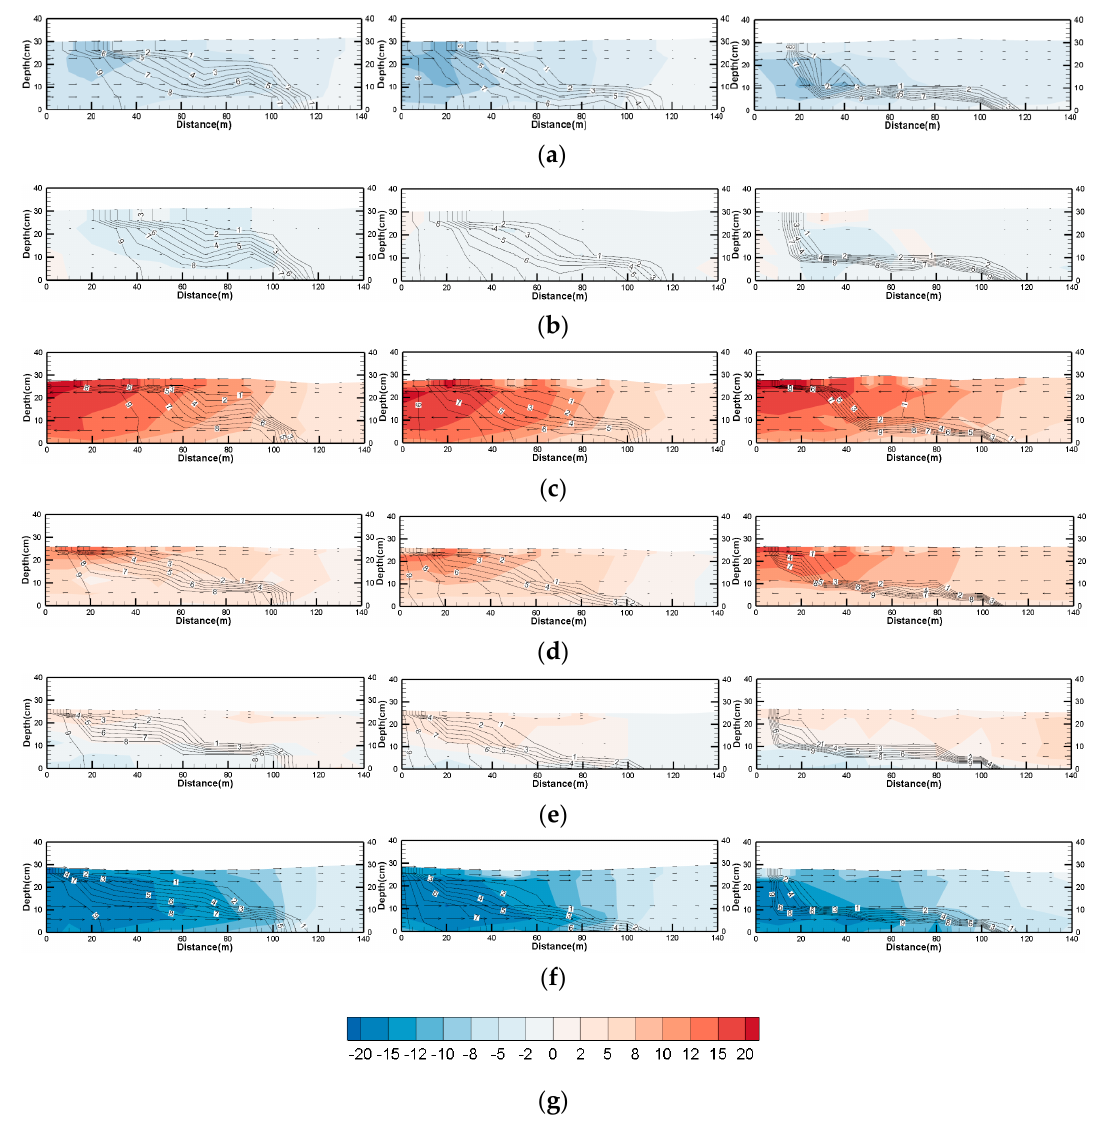
Figure 4. Salinity and velocity profiles of Case 3 (left figures), Case 4 (middle figures) and Case 5 (right figures) at each characteristic moment. ( a ) High water; ( b ) Flood slack; ( c ) Maximum ebb; ( d ) Low water; ( e ) Ebb slack; ( f ) Maximum flood; ( g ) Legend of velocity (unit: cm/s). The arrow represents the flow direction. The contour represents the isohaline.